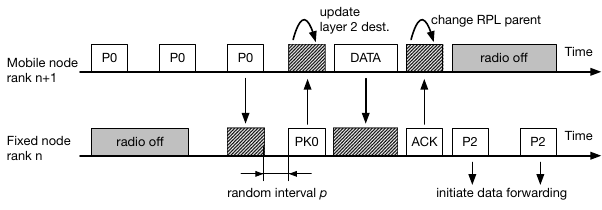
Figure 1. Preamble is acknowledged - Opportunistic